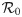
Simulation results of scenario 1 under three deferred vaccination campaign scenarios: 60 day delay in panels (a,b), 120 day delay in panels (c, d) and 180 day delay in panels (e,f).Black line with circles denote reported cases (e.g., in (a), in the form of square-root) and reported deaths (in (b), in the form of square-root), red line denotes model simulation median and blue dashed line is the fitted basic reproduction number, R0. Shaded region represents 95% range of 1,000 simulations. The vertical dashed line represents initiation of the vaccination campaign. The number of nodes, nm = 7, is adopted.